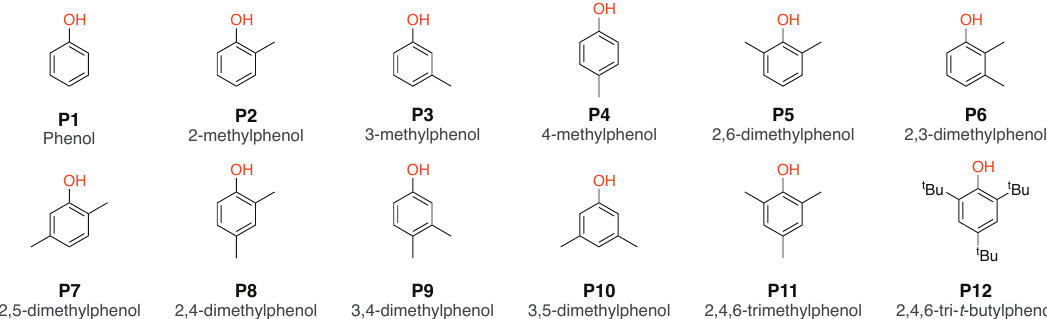
Figure 2. The chemical structures of the 12 phenols tested as anti-knock additives as part of this work. This family of compounds was selected to contain methodical structural variations to perturb both their efficacy as anti-knock additives and the thermodynamic and kinetic physical